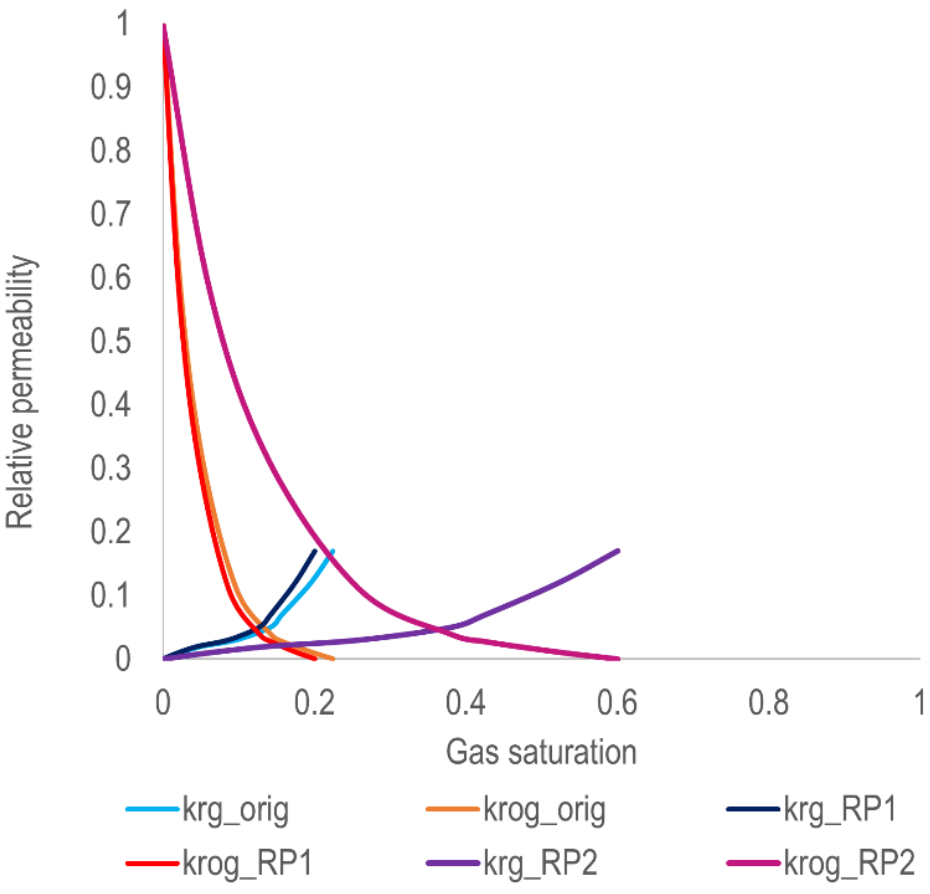
Figure 4. Effect of relative permeability curves, input data.